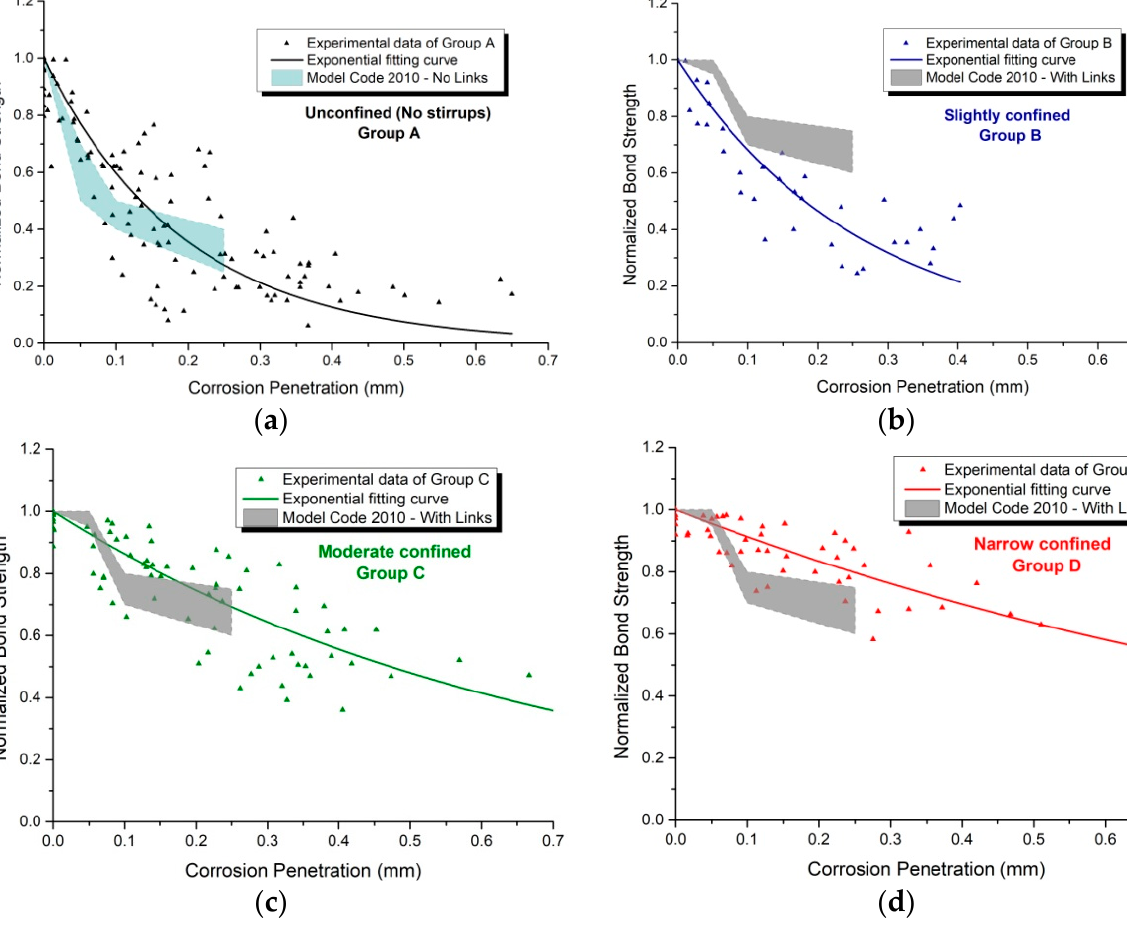
Figure 8. Extracted exponential fitting curves of bond loss as a function of corrosion penetration depth, for each confinement level group. ( a ) Unconfined specimens, ( b ) Slightly confined specimens, ( c ) Moderate confined specimens, ( d ) Narrow confined specimens. Table 4. Parameters by regression analysis for the exponential predictive